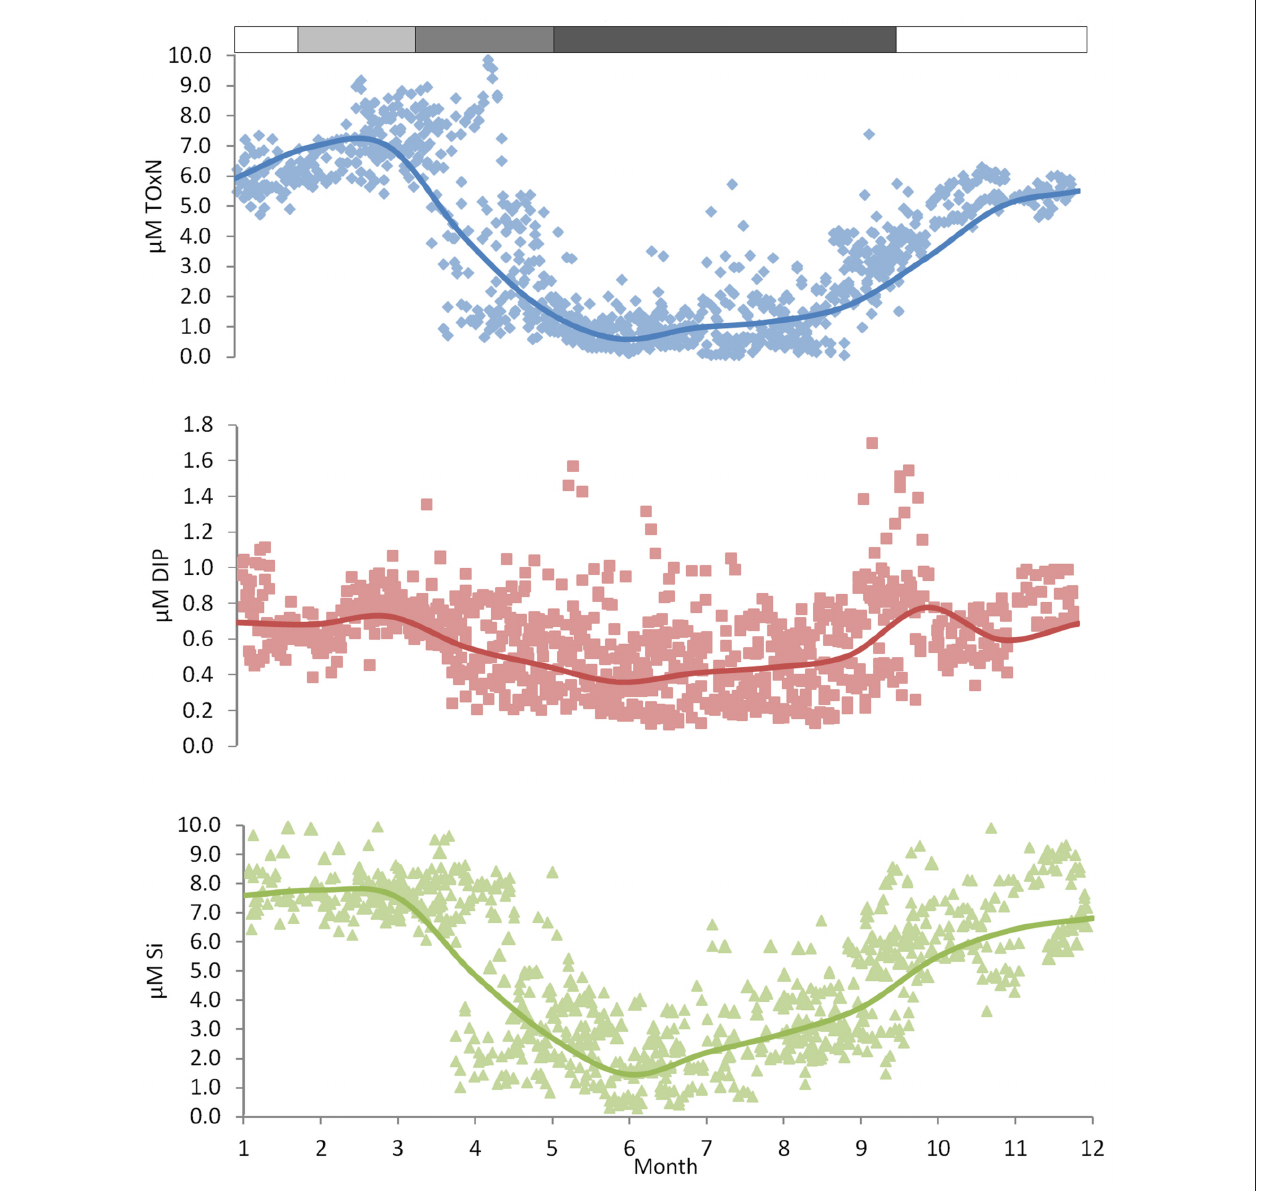
FIGURE 5 | Nutrient climatologies for the near surface seasonal inorganic nutrient cycle in µ M (ToxN, total oxidized Nitrogen; DIP, dissolved inorganic phosphorous; Si, dissolved silicate) for the period between 2010 and 2014 at station 38A in WIS (methods in Gowen et al., 1995) with the solid line displaying the mean value; the horizontal bar indicates the salinity and temperature contribution to the overall